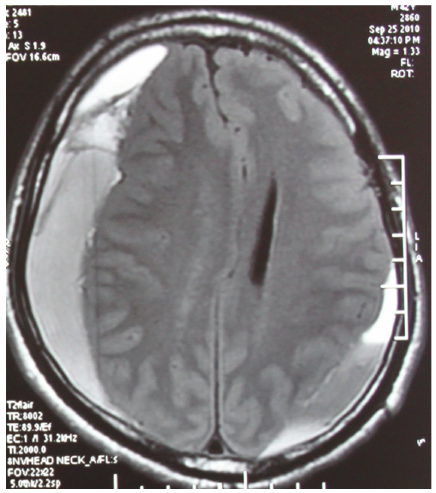
Figure 1: Pre-ECT cranial magnetic resonance imaging with contrast done to rule out organic causes of depression showing normal study.